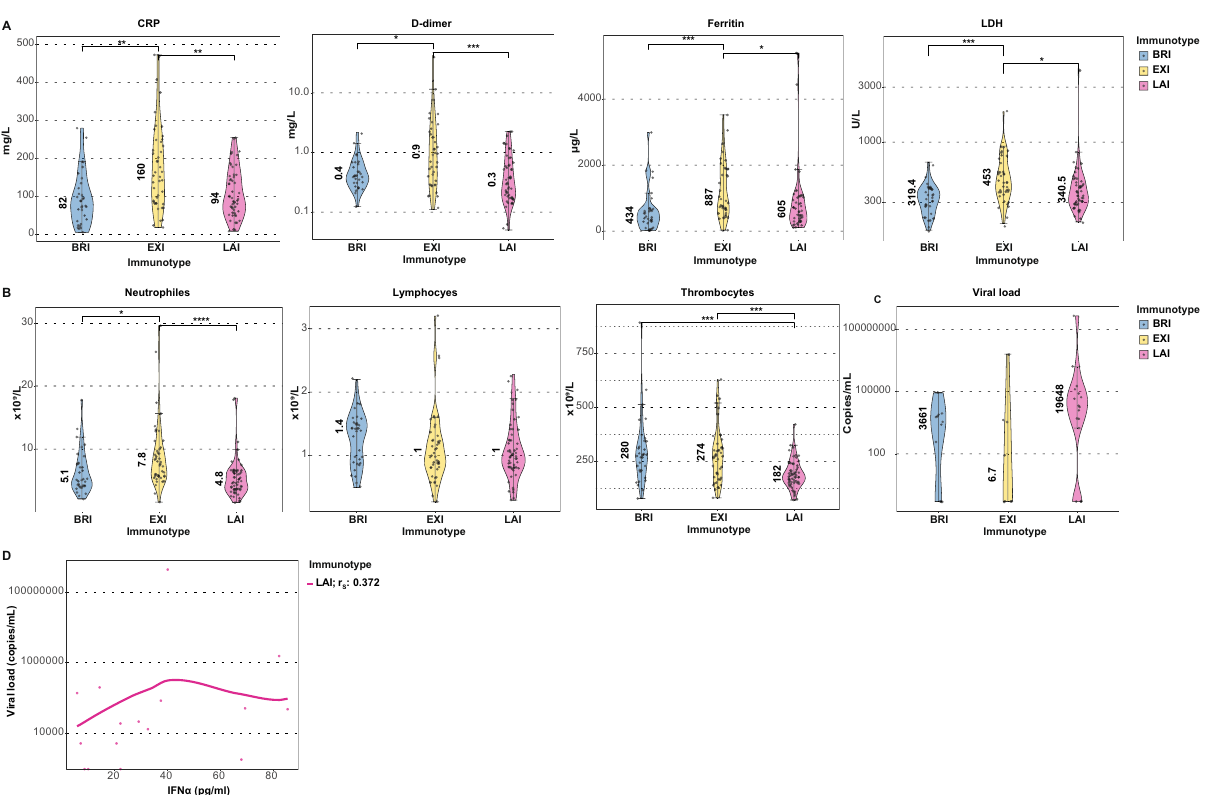
Fig. 5 Immunotypes differ in their clinical laboratory characteristics. A Violin plots of CRP, d-dimer, ferritin and LDH measurements shown. B Violin plots of blood neutrophil, lymphocyte, and thrombocyte counts. Data from BRI ( n = 33), EXI ( n = 46), and LAI ( n = 59) patients are shown. C Viral loads of immunotypes at entry shown (BRI n = 11, EXI n = 8, and LAI n = 16). Medians shown by number in plots. Whiskers indicate the 1.5x IQR value. D The scatterplot of IFN α and viral loads in LAI patients shown. Line depicts the non-parametric local polynomial regression line plotted using the locally estimated scatterplot smoothing (LOESS) method. Spearman ’ s rho ( r s ) is indicated. Correlation was not signi fi cant. A subgroup of Rotterdam patients ( n = 35) with nasopharyngeal viral load measurements are shown in C and D . Two-sided Wilcoxon rank-sum tests with Bonferroni correction were applied for each measurement in A – C . * p < 0.05, ** p < 0.01, *** p < 0.001, and **** p <